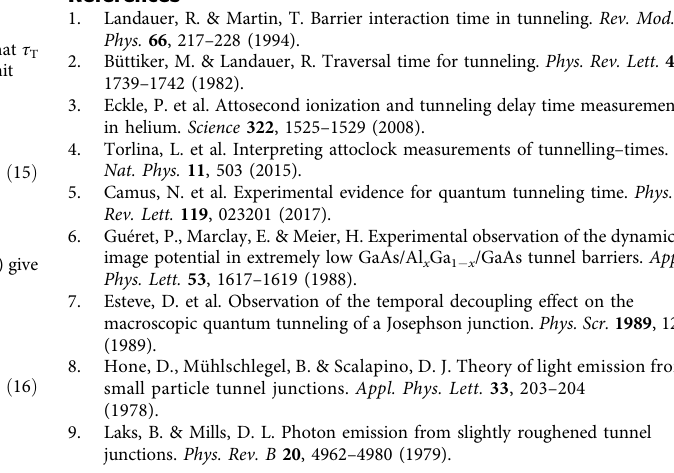
ffiffiffiffiffiffiffiffiffiffiffi ffiffiffiffiffiffiffiffiffiffiffiffiffiffi 8 mUd 2 : ð 14 Þ and ϵ 0 ¼ ffiffiffiffiffiffiffiffiffiffiffiffiffiffiffiffiffiffiffiffiffi p md 2 = ð 2 U Þ